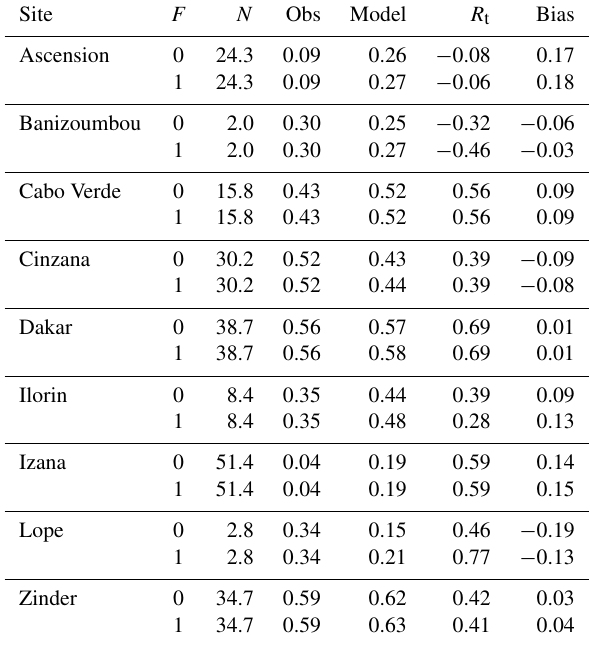
Table 2. Correlations between observations (AERONET) and the model (CHIMERE PR2) for aerosol optical depth (AOD). F is 0 for the NoFIRE simulation and 1 for the simulation with fire emis- sions. N is the percentage of hourly available measurements, R t is the temporal correlation, and the bias is calculated by using the dif- ference (model minus